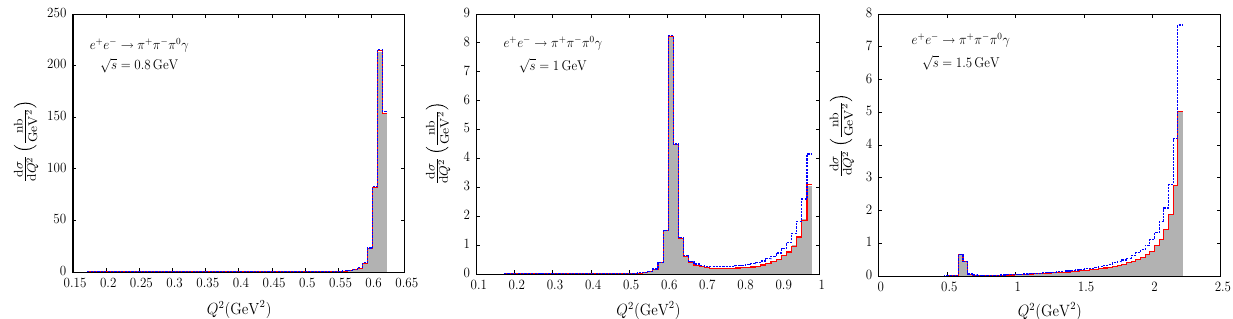
Fig. 13 The differential cross sections of (13) as functions of invariant mass of the π + π − π 0 -system. Legend as in Fig. 11